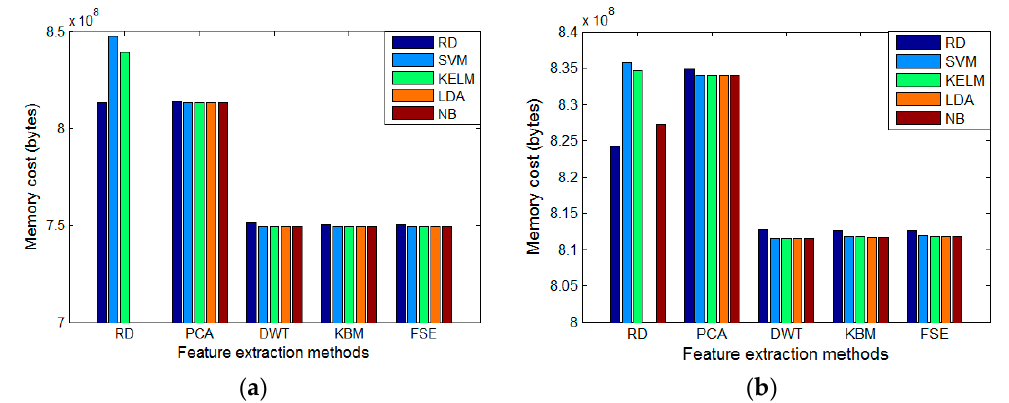
Figure 3. Memory cost: ( a ) Our own dataset. ( b ) Public benchmark .